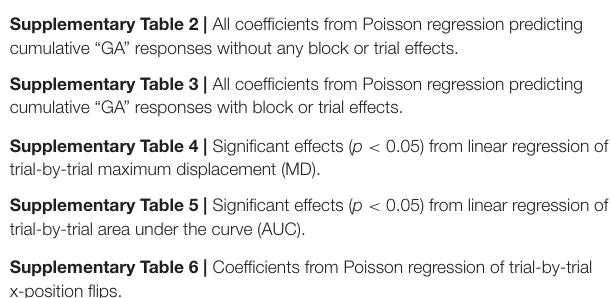
Supplementary Table 6 | Coefficients from Poisson regression of trial-by-trial x-position